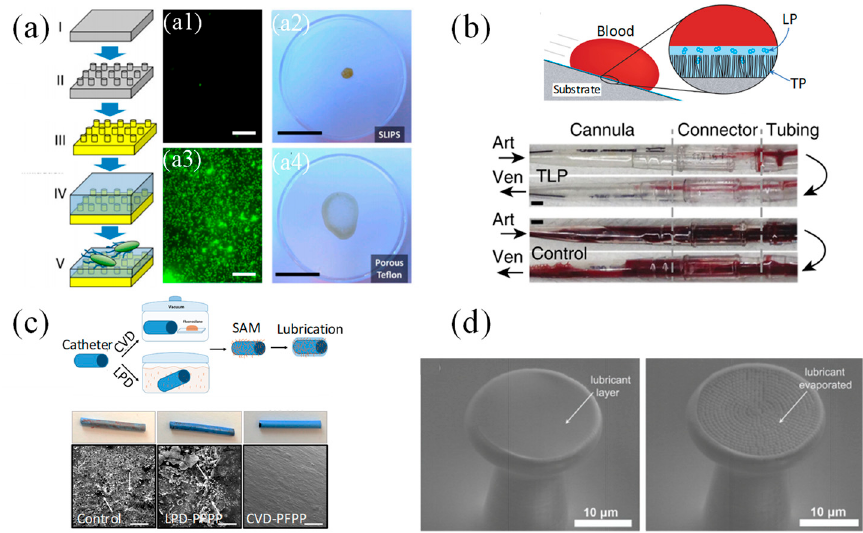
Figure 8. ( a ) Fabrication process of SLIPS surface using porous substrate and bio-fouling experiment with and without liquid infusion. Reproduced with permission from [109], published by PNAS, 2012. ( b ) SLIPS surface fabricated with liquid soaking deposited self-assembled monolayers (SAM). Reproduced with permission from [111], published by Nature, 2014. The experimental results showed TLP modified tubing and control tubing after 8h of blood flow. The blood flow through arterial (Art) or venous (Ven) cannula was indicated by the black arrow. ( c ) SLIPS surface fabricated with both liquid soaking and vapor deposited SAM. Reproduced with permission from [112], published by Nature, 2017. ( d ) SEM images of SLIPS and doubly re-entrant superomniphobic composite structures. The left image shows the surface with lubrication and the right image shows the surface after lubricant evaporation. Reproduced with permission from [115], published by Wiley Online Library, 2018.